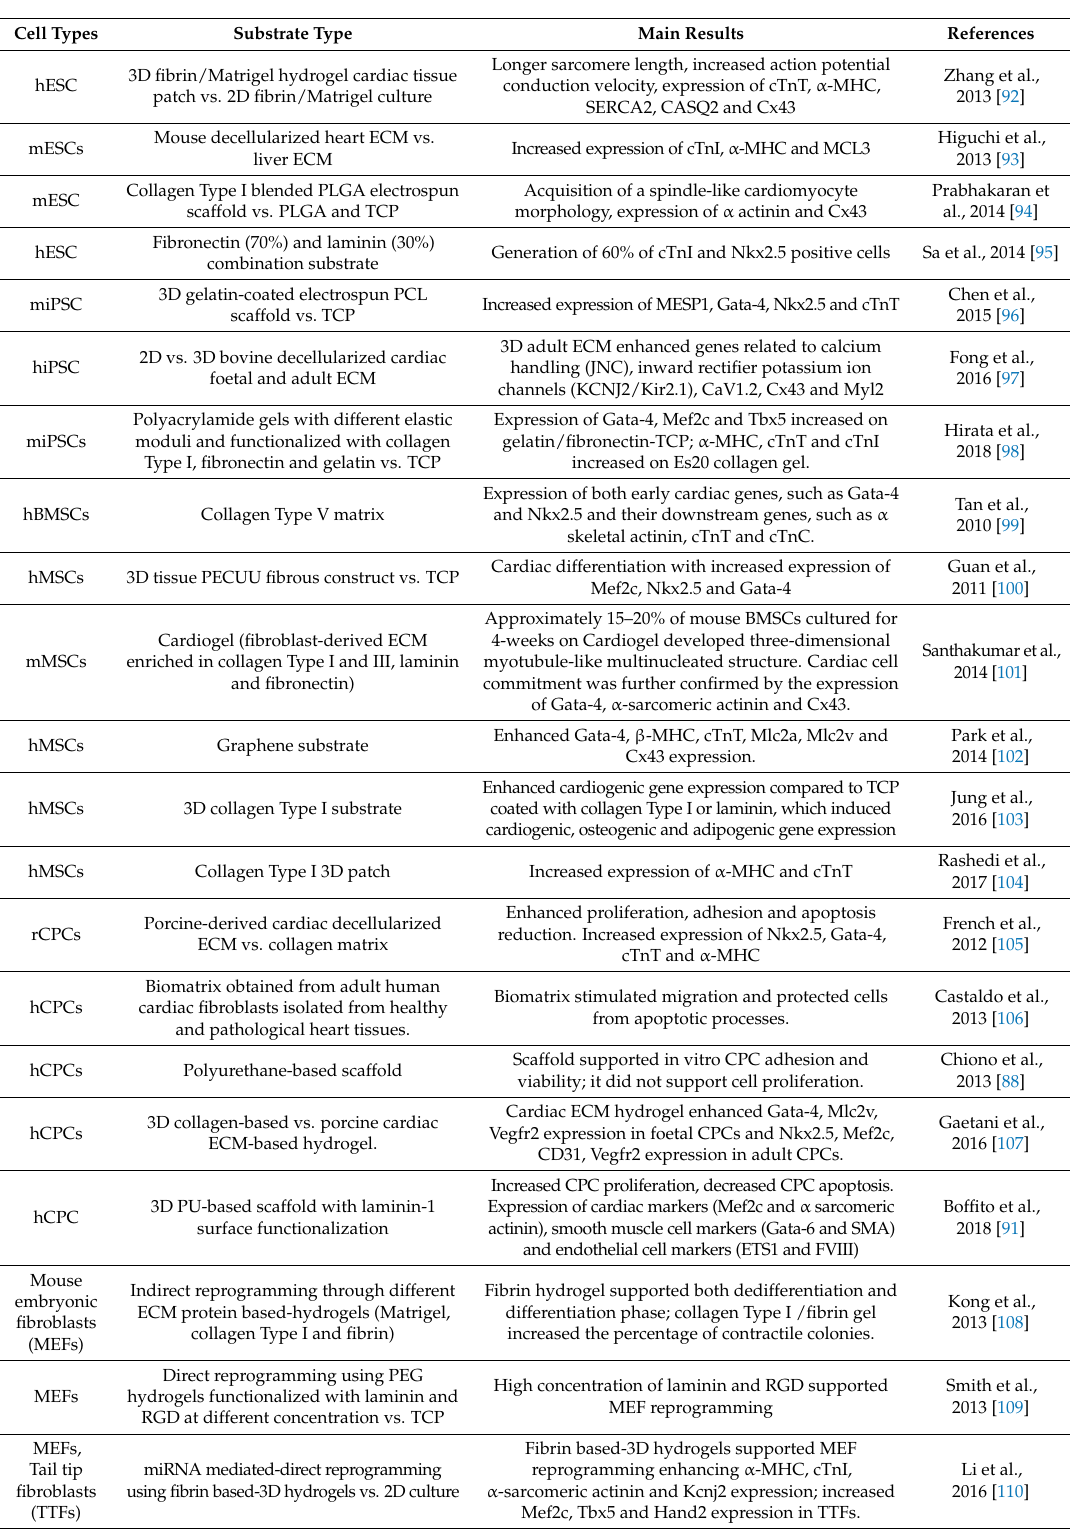
Table 1. Influence of different biomaterial substrates on stem cell differentiation and fibroblast (direct and indirect) reprogramming into